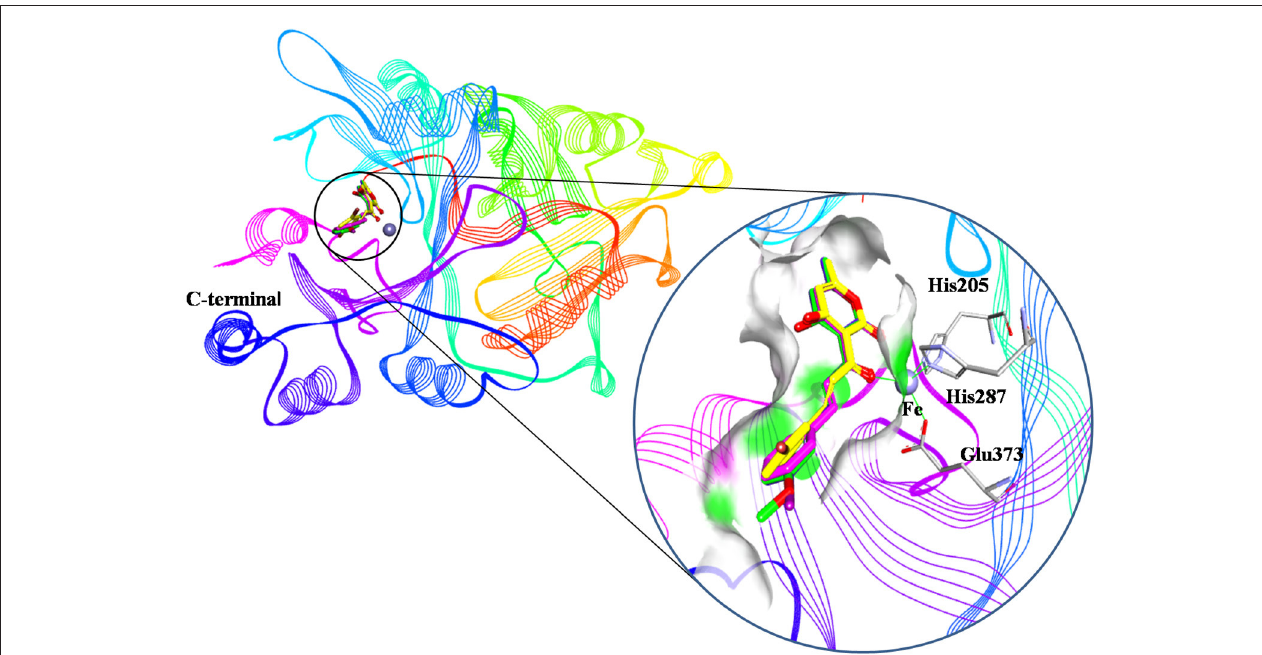
FIGURE 9 | Binding modes of compounds at active pocket. Blue, green, yellow, and pink represented compound 3885, compound 3882, compound 4293, and compound 3881, respectively.